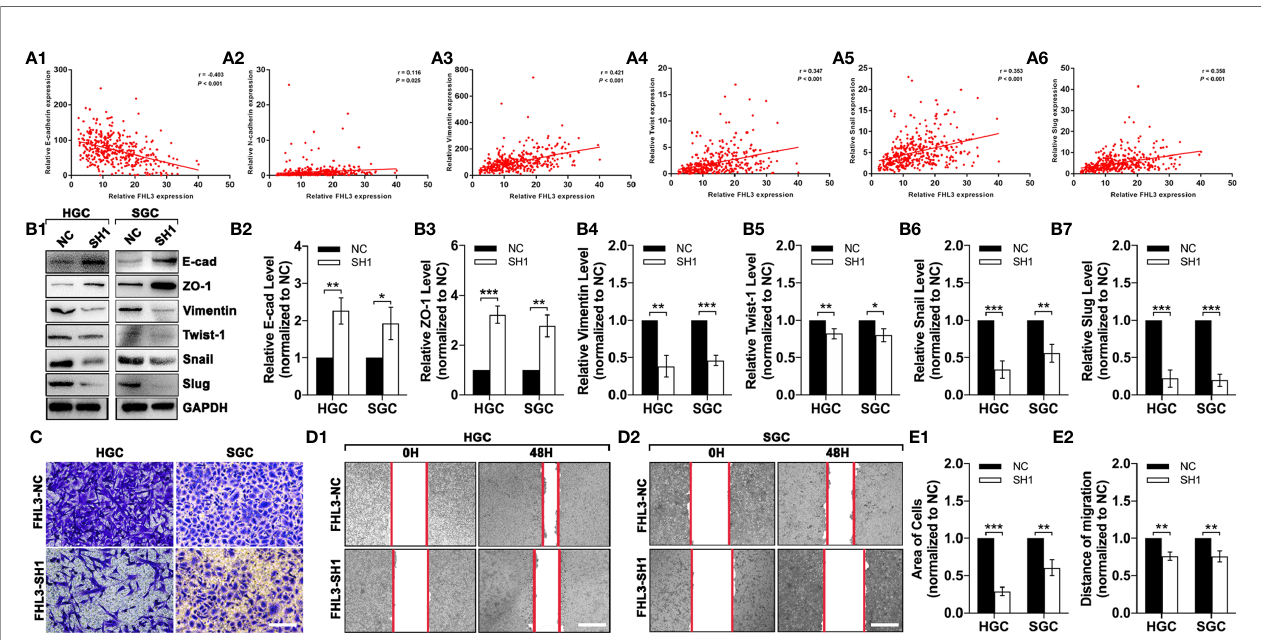
FIGURE 4 | FHL3 knockdown reversed the EMT process in gastric cancer. (1) The relationship between FHL3 and EMT-associated transcriptional factors (Snail1, Slug, Twist), and EMT markers (N-cadherin, E-cadherin and Vimentin) (A 1 – 6 ) ; (2) FHL3 knockdown reversed the EMT process and was veri fi ed by western blot in FHL3-NC and SH1 cell lines (B 1 – 7 ) ; (3) The effects of FHL3 knockdown in migration and invasion were explored by transwell (200× magni fi cation) and wound healing assay (40× magni fi cation) in in OHP-resistance FHL3-NC and SH1 cell lines (C, D 1 – 2 and E 1 – 2 ) .